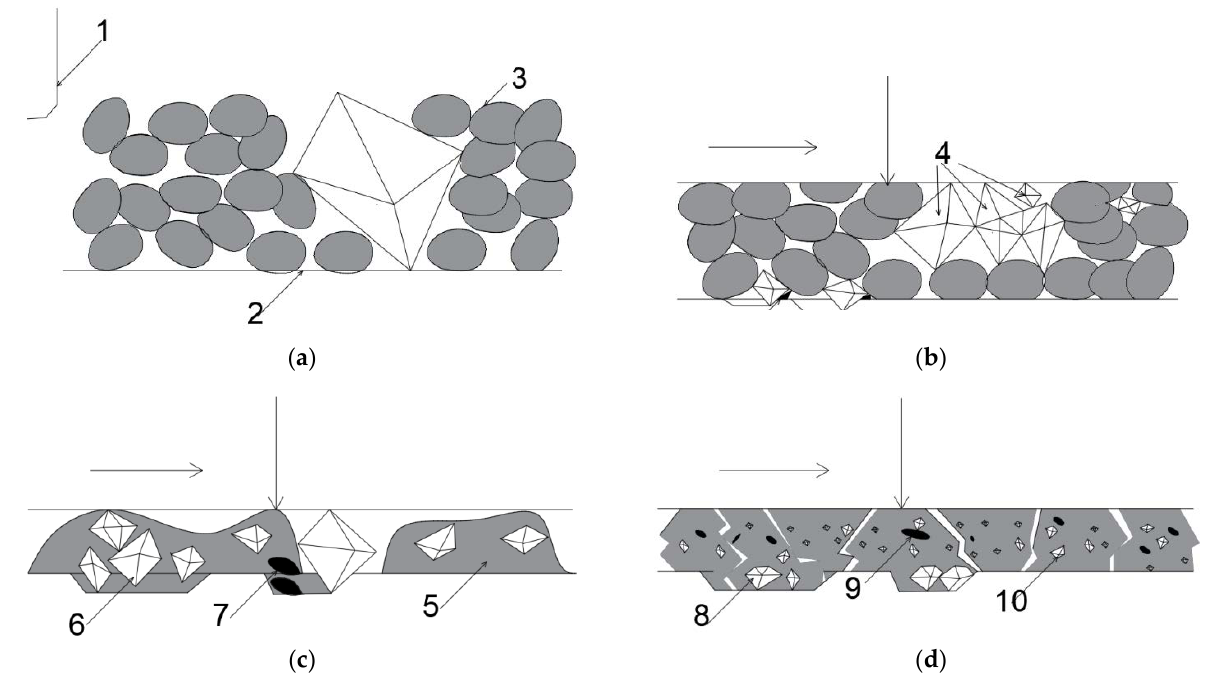
Figure 18. Model of wear with the presence of a coal-mineral mixture of a real system: a scraper sliding on the metal sheet surface, ( a )—Stage I (initial state), ( b )—Stage II (initial cutting of the steel surface by crushed and uncrushed mineral grains and initial coal consolidation under load and the scraper advance), ( c )—Stage III (deposition of abrasive grains in coal-filled cutting areas or cracks), ( d )—Stage IV (smoothing the mineral grains protruding above the surface level); symbols: 1—scraper, 2—metal sheet, 3—coal grains, 4—crushed mineral particles, 5—pre-consolidated coal fractions, 6—grains of hard abrasive embedded in the surface cavities, 7—wear debris, 8—smoothened mineral grains, 9—crushed particle of removed steel, 10—fully crushed mineral grains.